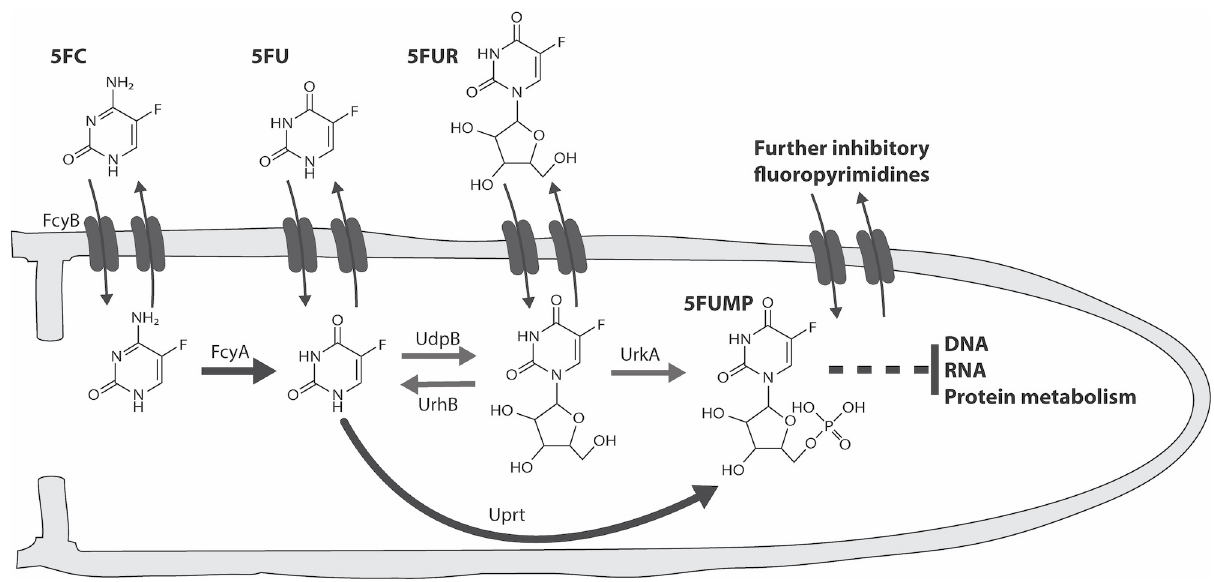
Fig 6. Proposed model illustrating transport dynamics and pyrimidine salvage activities that mediate the metabolic conversion of fluoropyrimidines in A . fumigatus . The major route of 5FC metabolic activation is catalyzed by FcyA and Uprt (black arrows). UdpB, UrhB and UrkA constitute enzymes of a metabolic bypass (grey arrows) that generates 5FUMP, however in a less efficient way. During 5FC treatment, intracellular levels of 5FC, 5FU, 5FUR and so far unknown fluoropyrimidine antimetabolites are reduced by their export into the environment.